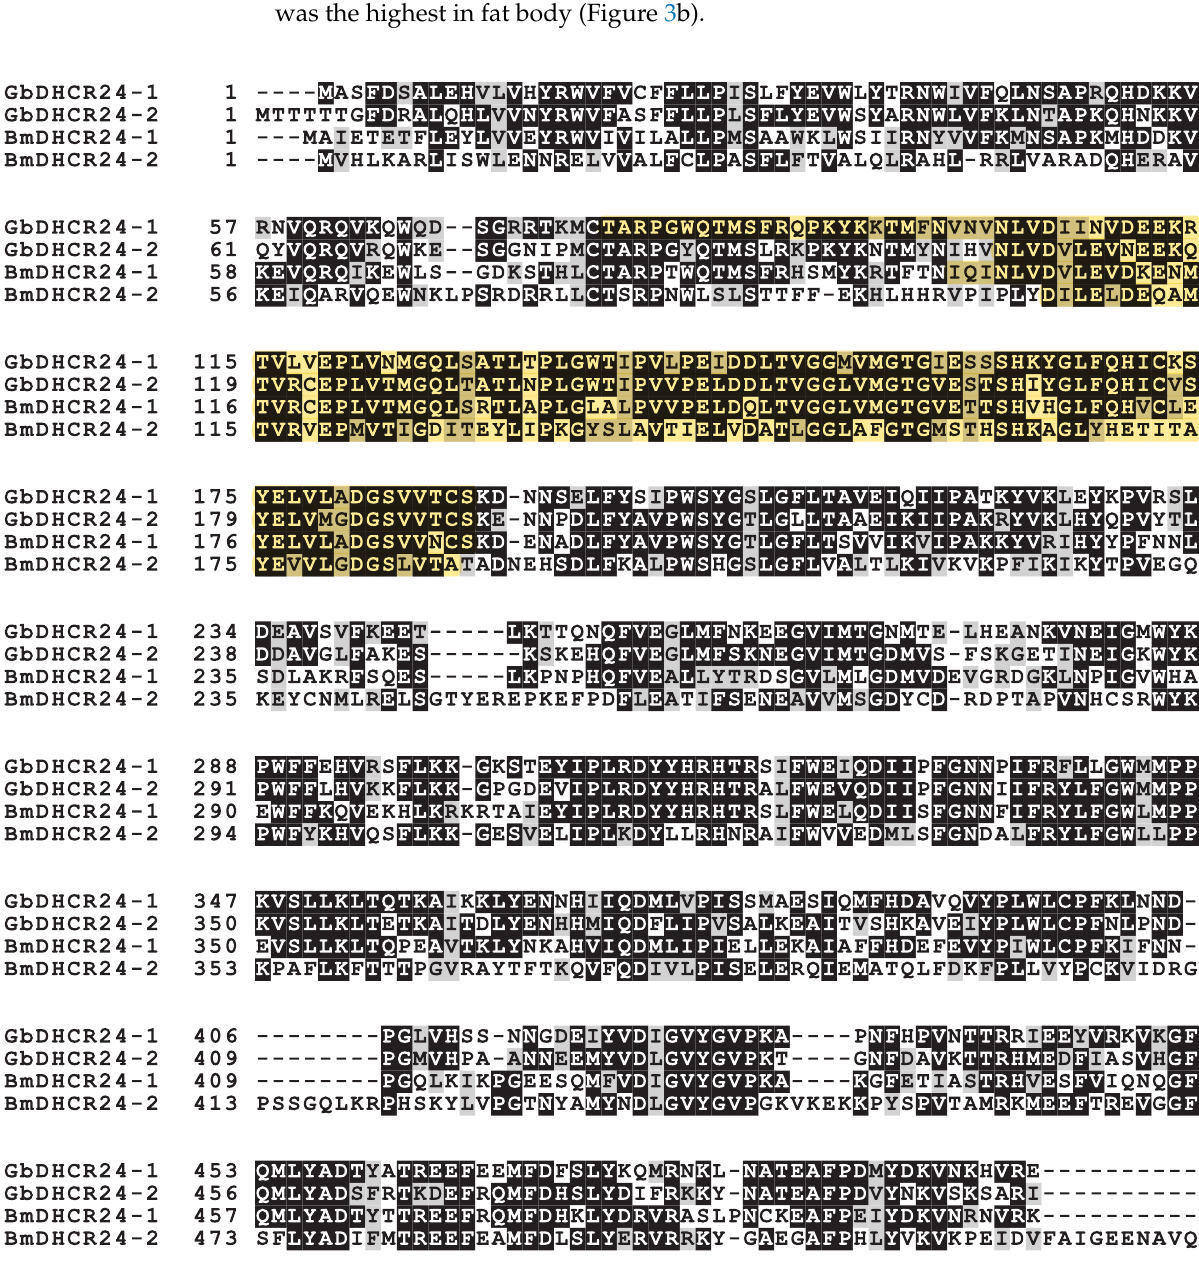
Figure 1. Alignment of G. bimaculatus DHCR24s (GbDHCR24-1 and GbDHCR24-2) and B. mori DHCR24 (BmDHCR24-1 and BmDHCR24-2). Identical amino acids at the same position are shaded in black, and similar amino acids at the same position are shaded in pale grey. The region matching the FAD binding domain on the Pfam database is highlighted in